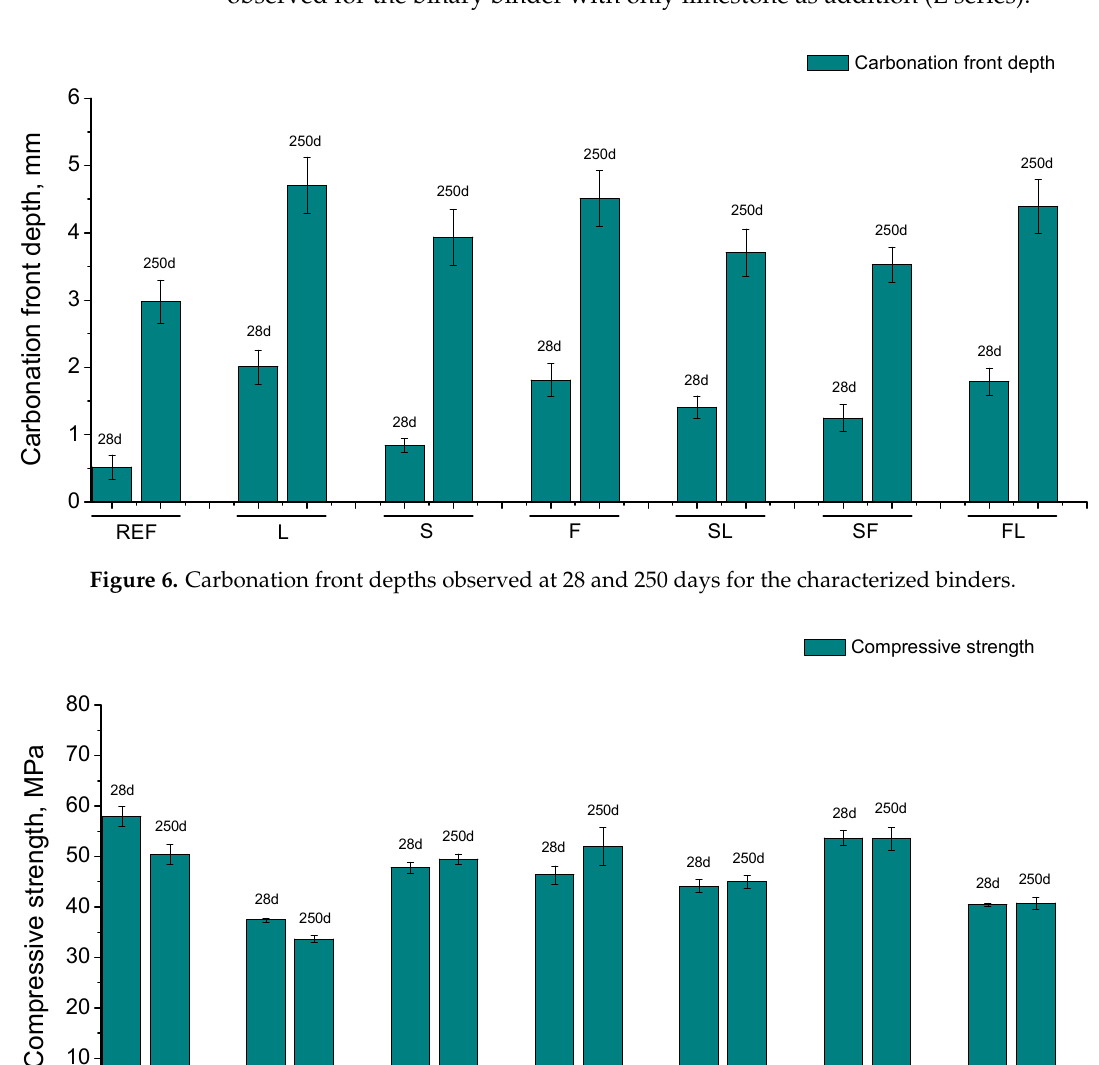
Figure 5. Steady-state chloride diffusion coefficient results obtained for the analyzed mortars.